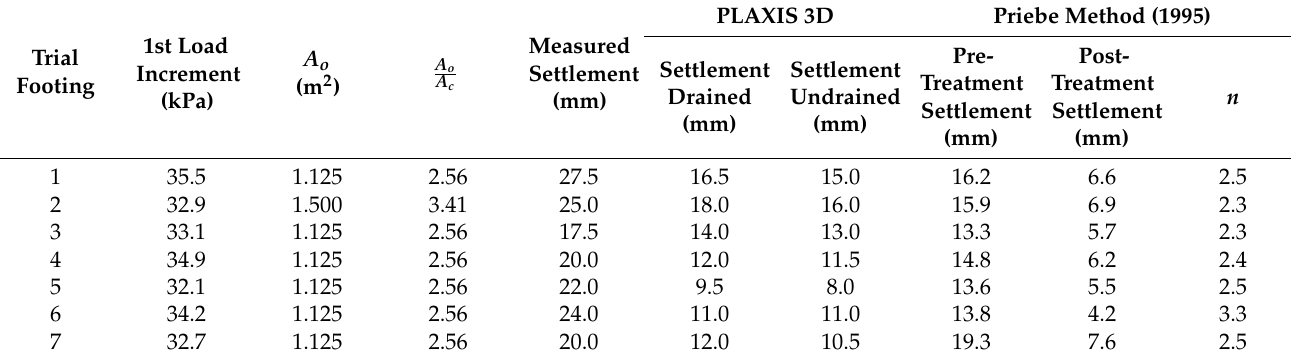
Table 7. Measured [36], predicted settlement with PLAXIS 3D and estimated settlement with the Priebe (1995) method for the trial footings under the first load